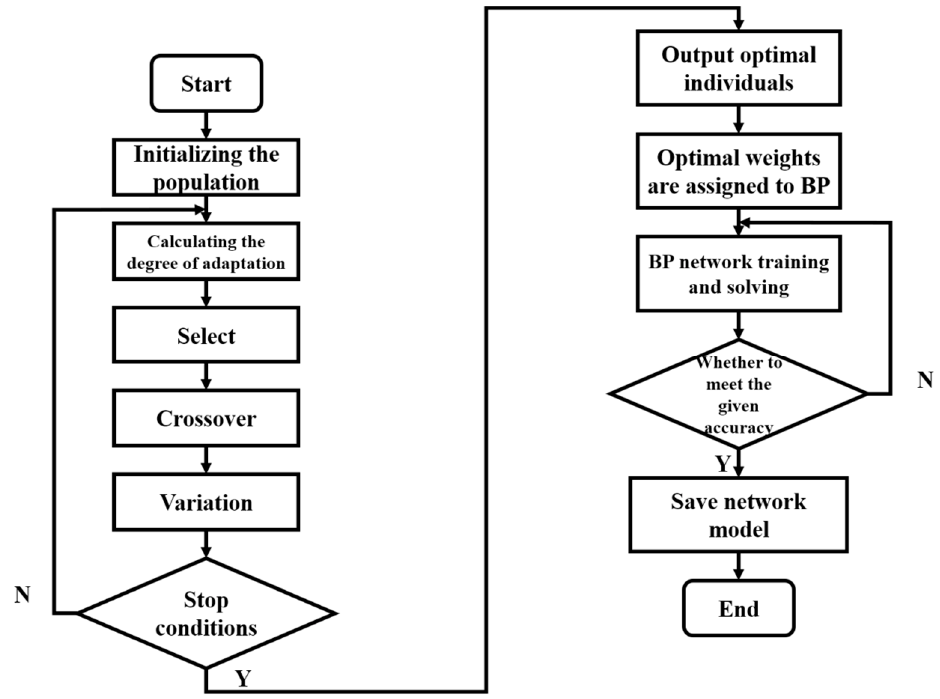
Figure 3. Genetic algorithm optimization process.